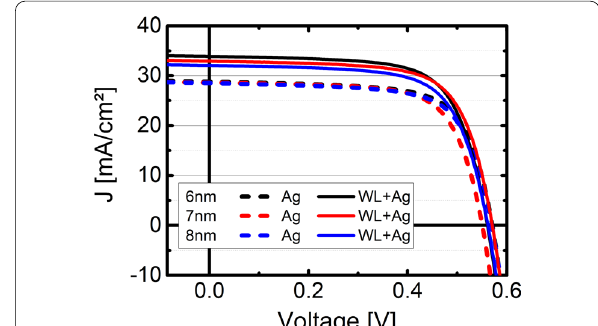
Fig. 3 Current density–voltage characteristics of CIGS cells using electrodes with (full lines) and without (dashed lines) wetting layers for the three thickness levels of the Ag layer are compared. The best performing cell from the set of nine cells structured on each sample is shown